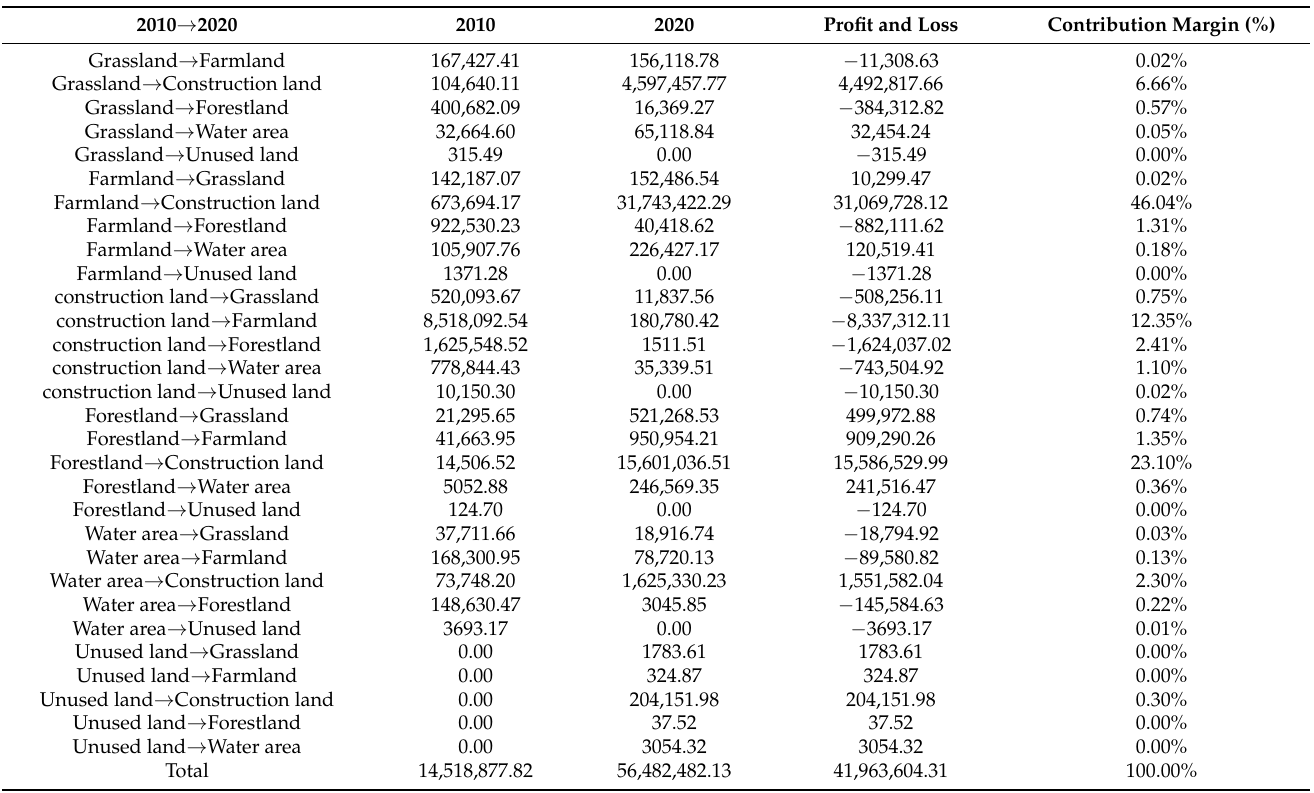
Table 4. Effect of land consolidation before and after on the quantity of economic value (104 yuan).